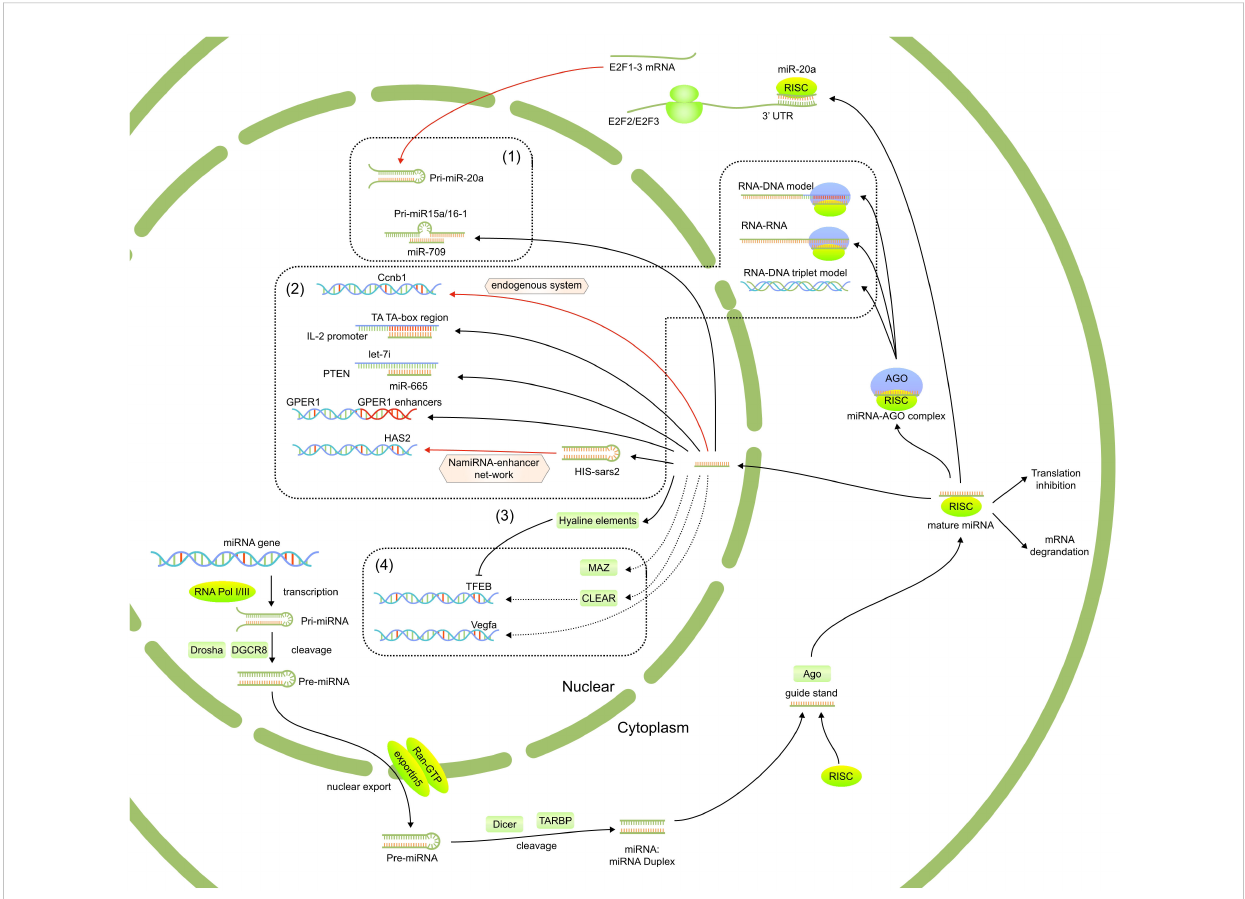
FIGURE 1 The reported functions of nuclear miRNAs, including 1)regulated the biogenesis and fuctions of other miRNAs, 2) targeted gene promoter or enhanced elements, 3) affect post-transcriptional regulation of mRNAs in the cytoplasm through nuclear translocation and 4) regulate potential signaling